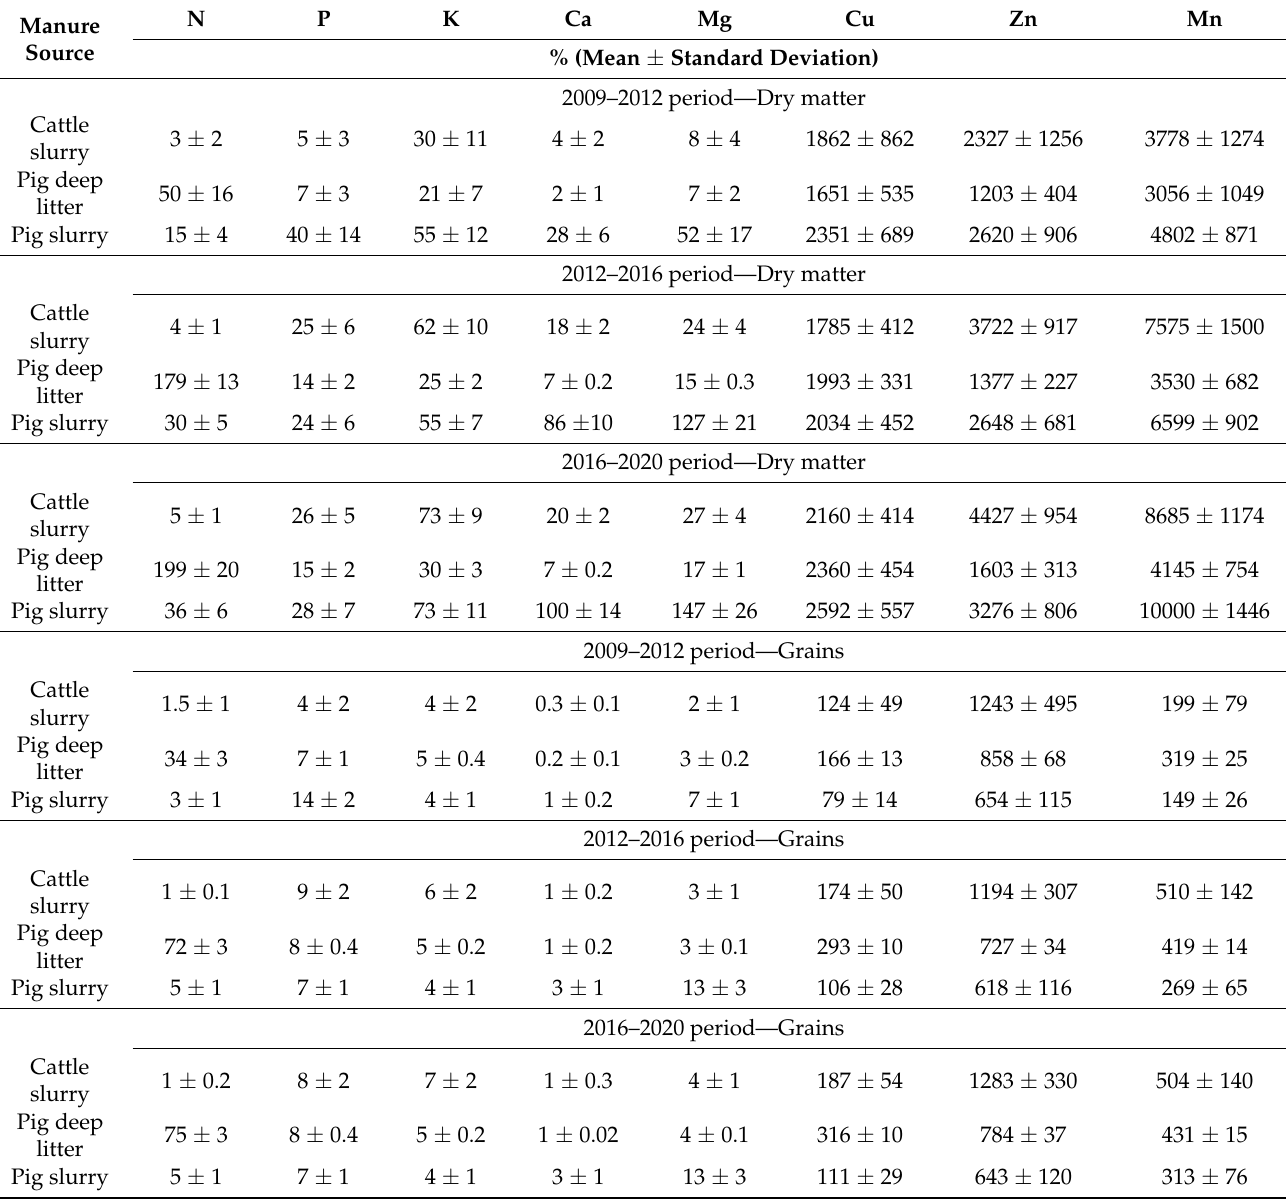
Table 4. Apparent nutrient recovery (ANR) of N-based manure fertilization compared to mineral fertilization